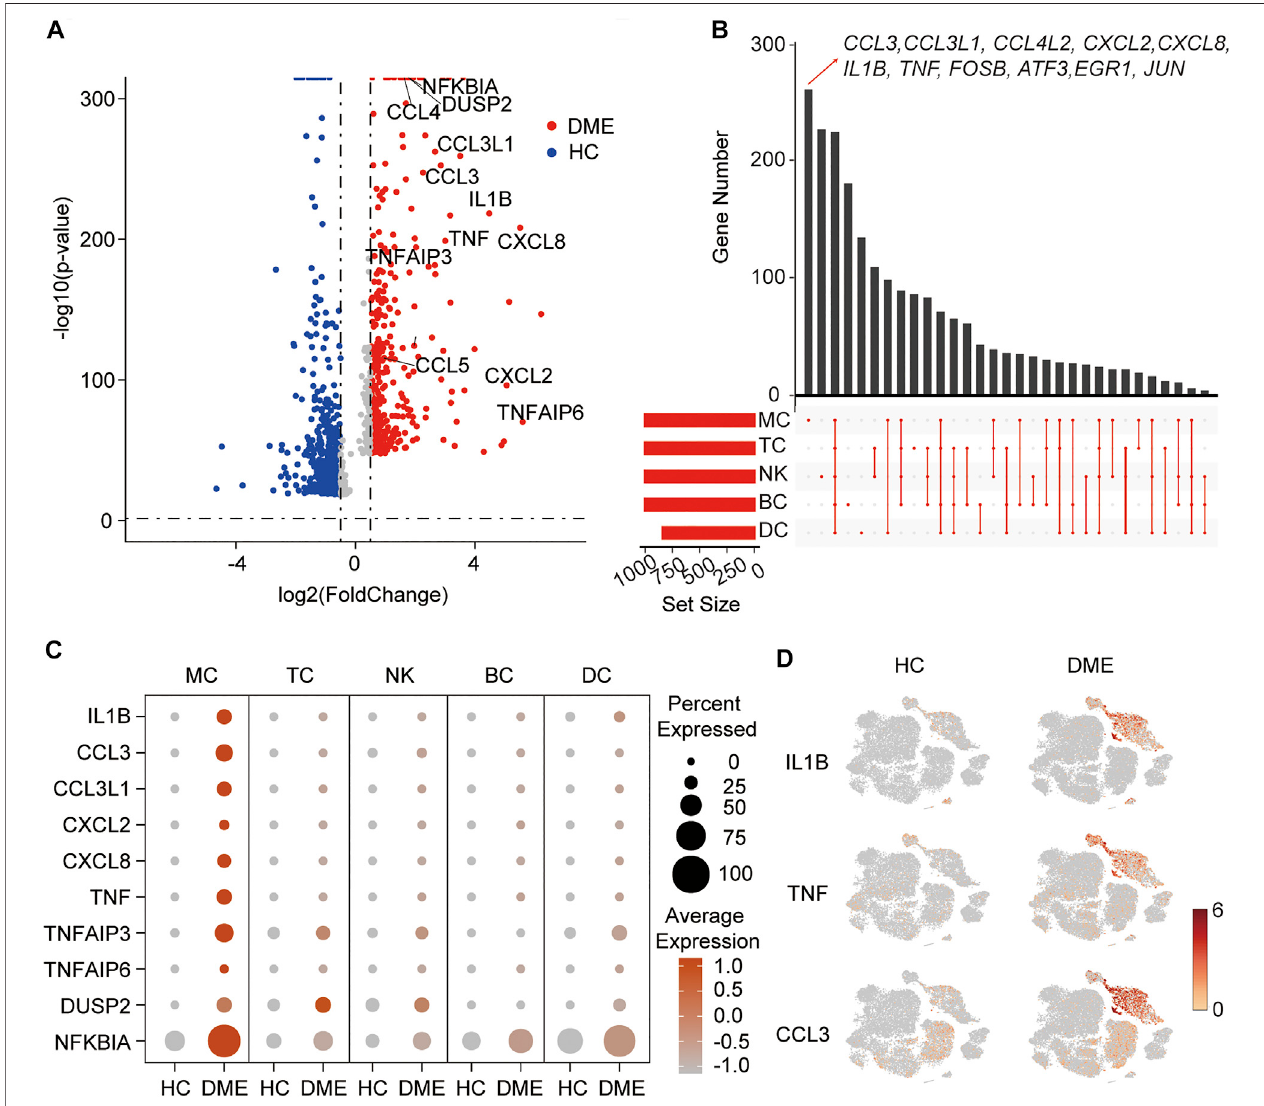
FIGURE2 | Aproin fl ammatoryphenotype mediated byMC in DME patients. (A) Volcano plotshowingup-regulated and down-regulatedDEGs ofall immune cells in DMEcompared toin HC(DME:red;HC:blue). DEG:differentialexpression gene. (B) Vennplotshowing uniqueupregulatedgenesexpressed in MC,DC, TC,NKand BCfromDMEcompared totheonesfromHC. (C) Thedotplotshowingtheexpressionofin fl ammatorygenesinthe fi vemajorcellclustersfromtheHCandDMEgroup. (D) The feature plot showing the expression of representative in fl ammatory genes, ILB , TNF , and CCL3 , in each cluster from the HC and DME group.